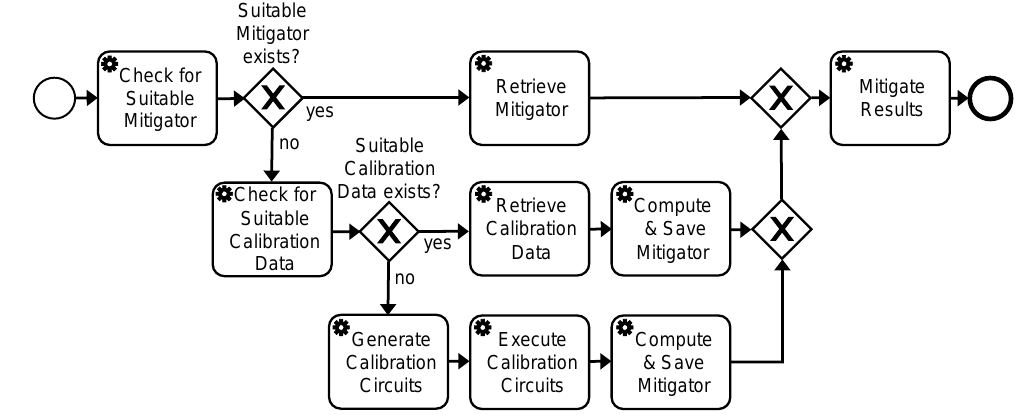
Figure 5. Exemplary REM workflow fragment for CM-based methods.